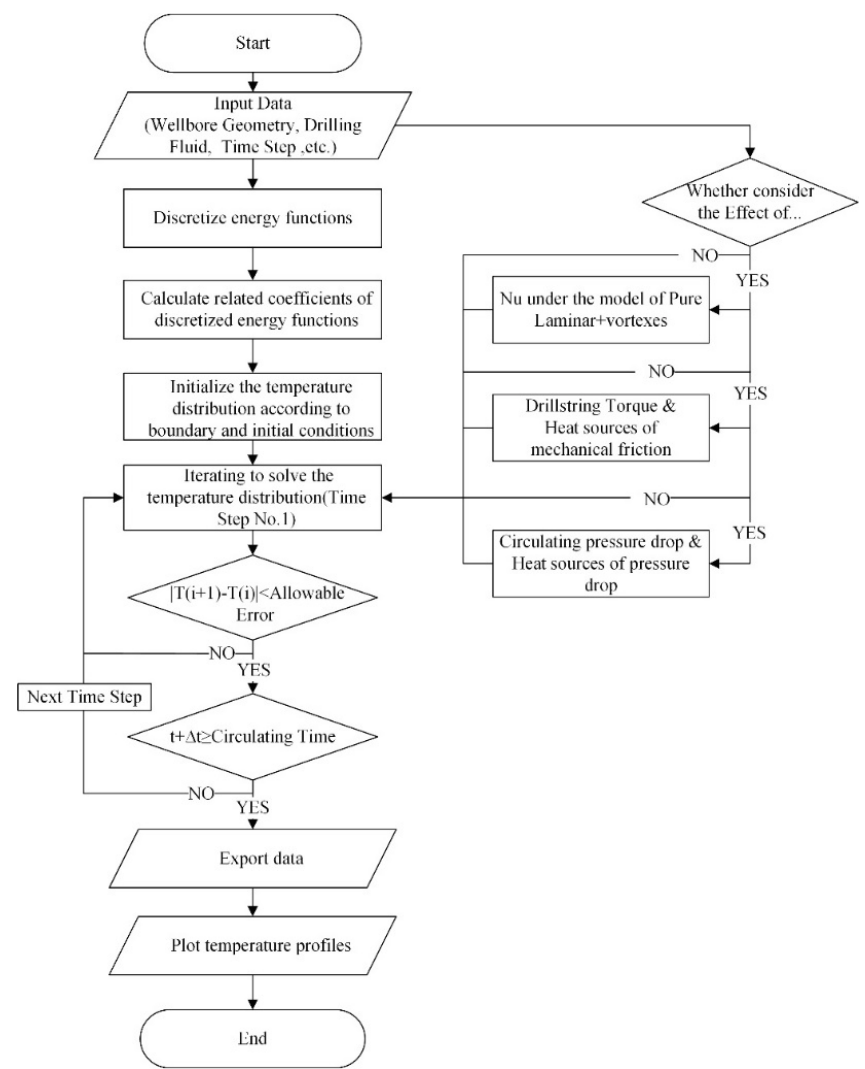
Figure A3. Well profile applied in this study.